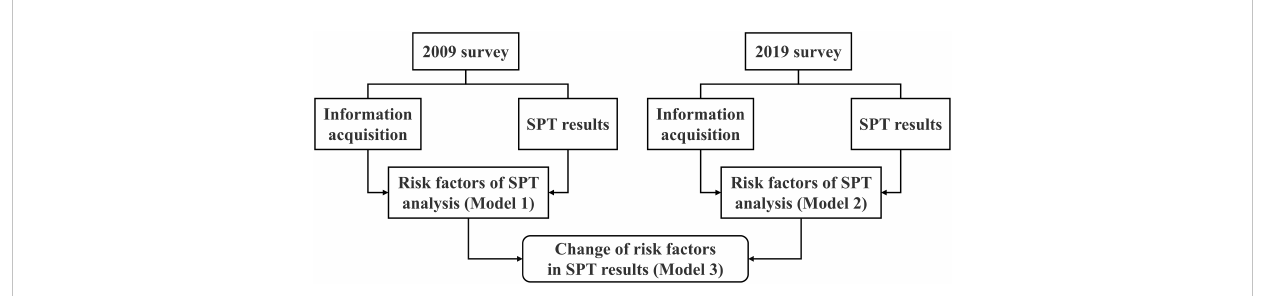
FIGURE 1 Study design and statistical process comparing change in food sensitization risk factors between the 2009 and 2019 surveys. SPT, Skin prick